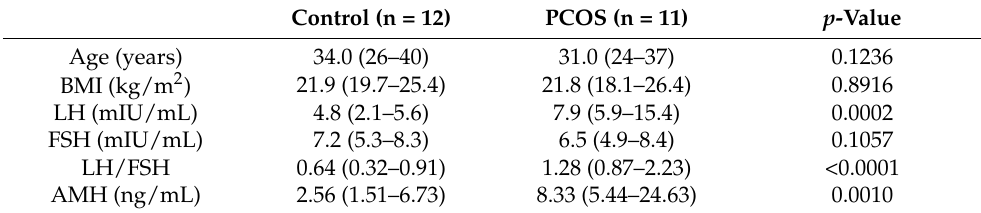
Table 1. Characteristics of the patients who provided follicular fluid